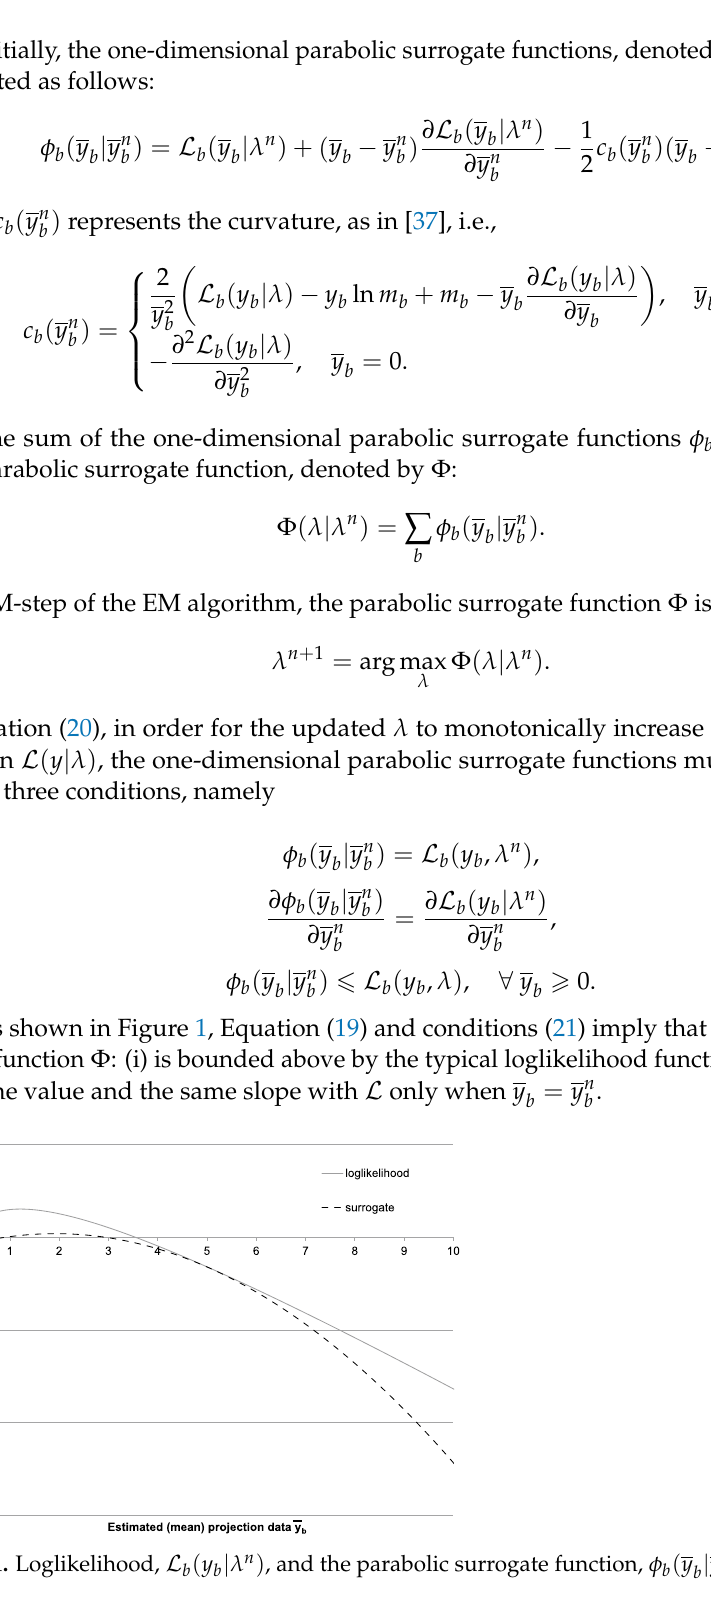
Figure 1. Loglikelihood, L b ( y b | λ n ) , and the parabolic surrogate function, φ b ( y